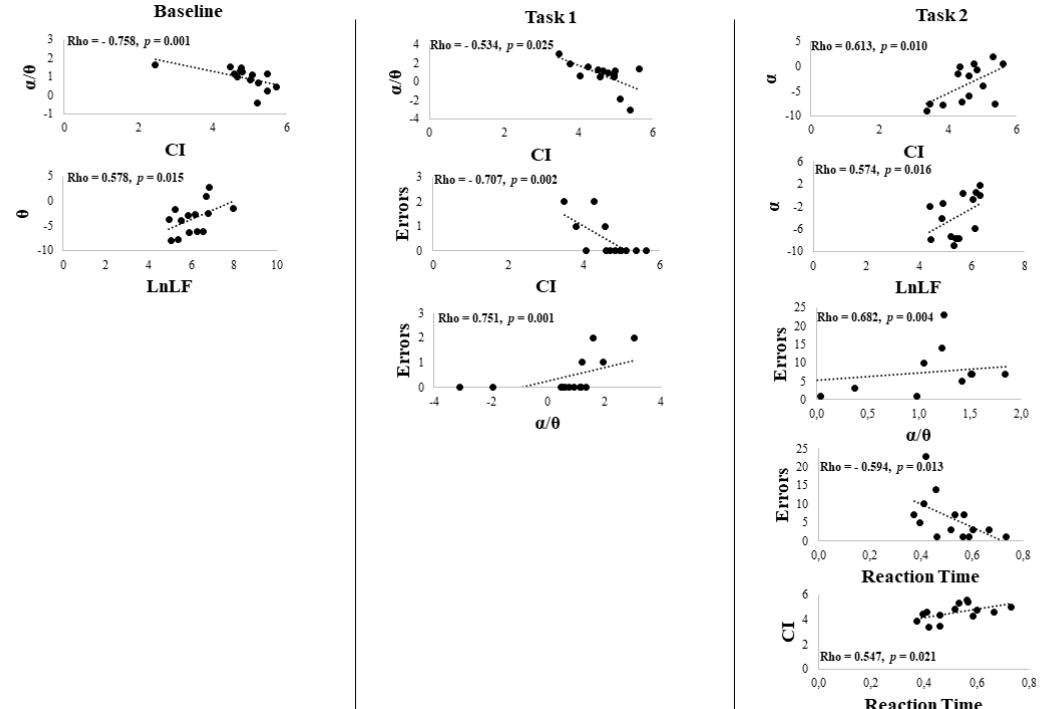
Figure 5. Scatter Plot of the correlation between HRV parameters (Complexity Index (CI), HF power (LnHF), LF power (LnLF)) and EEG α , ϑ , and α / ϑ ratio EEG powerbands of the whole group. The dashed line represents the tendency line.